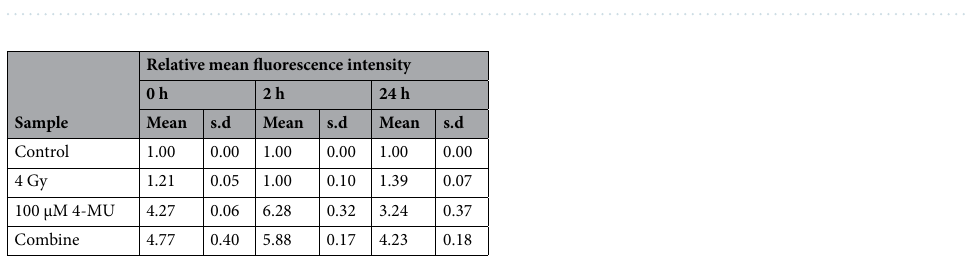
Figure 4. Flow cytometric patterns for the intracellular oxidative stress level. ( A ) Representative histograms and ( B ) the relative mean fluorescence intensity of the HT1080 cells. The mean fluorescence intensity of the 4 Gy irradiation alone group, 100 μM 4-MU treatment alone group, and combine group are standardized by the mean fluorescence intensity of the control group at each time. Note that asterisk (*) on the plot represents p < 0.05 compared to the 4 Gy irradiation alone group, and bracketed asterisk represents significant differences of p < 0.05 between the two groups.